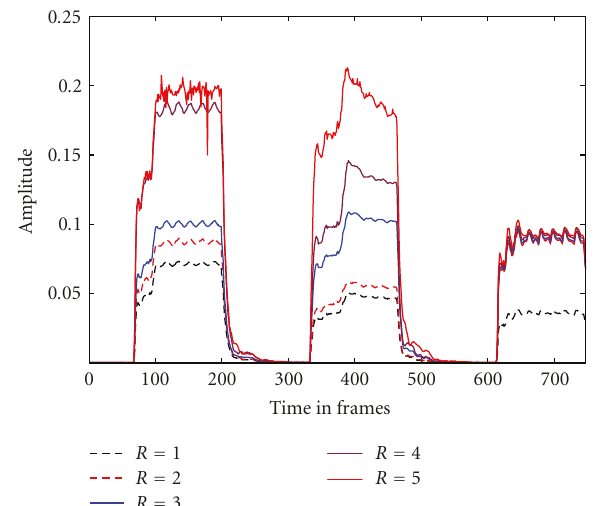
Figure 6: Temporal profile h o ( k ) changes with various R varying from 1 to 5.